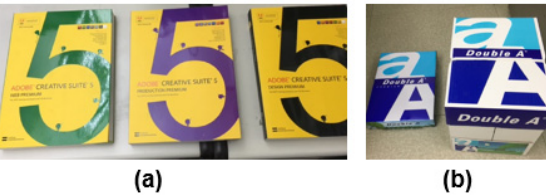
Figure 11. Examples of complex situations with similar shapes or the same feature sets in surrounding areas: ( a ) same shapes and different ‐ colored textures ( b ) same textures and different shapes.